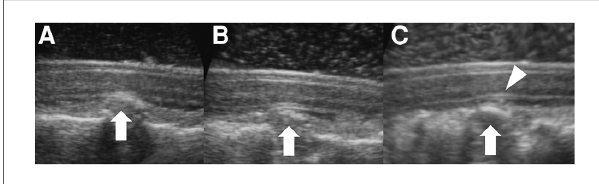
FIGURE 2 Intraoperative ultrasonography. After laminectomy. ( A ) The spinal cord is compressed anteriorly by ossi fi cation of the posterior longitudinal ligament (OPLL) (arrow). ( B ) Before resection of the PLL. After partial osteotomy of the posterior vertebra adjacent to the targeted OPLL and before PLL resection, the OPLL decreased (arrow). ( C ) After PLL resection. The OPLL further moves anteriorly ( arrow ), and a space between the spinal cord and dura mater is clearly detected ( arrowhead ).